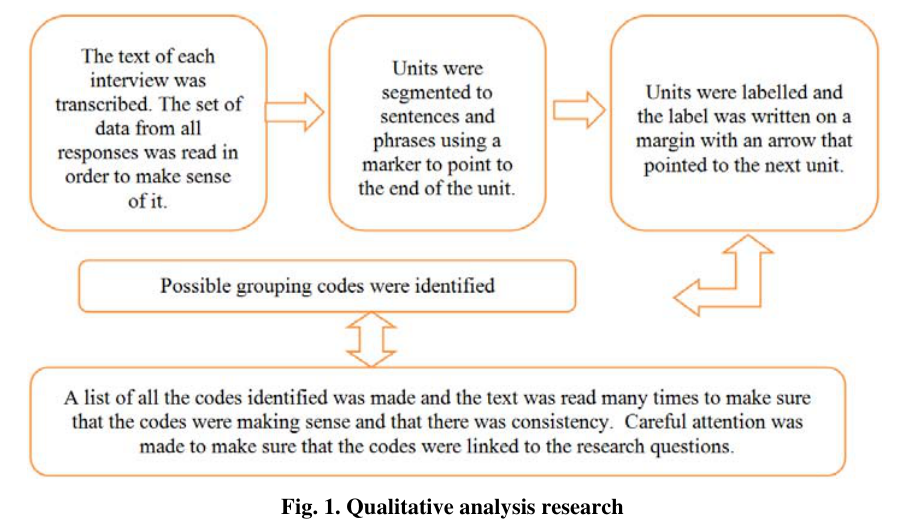
Fig. 1. Qualitative analysis